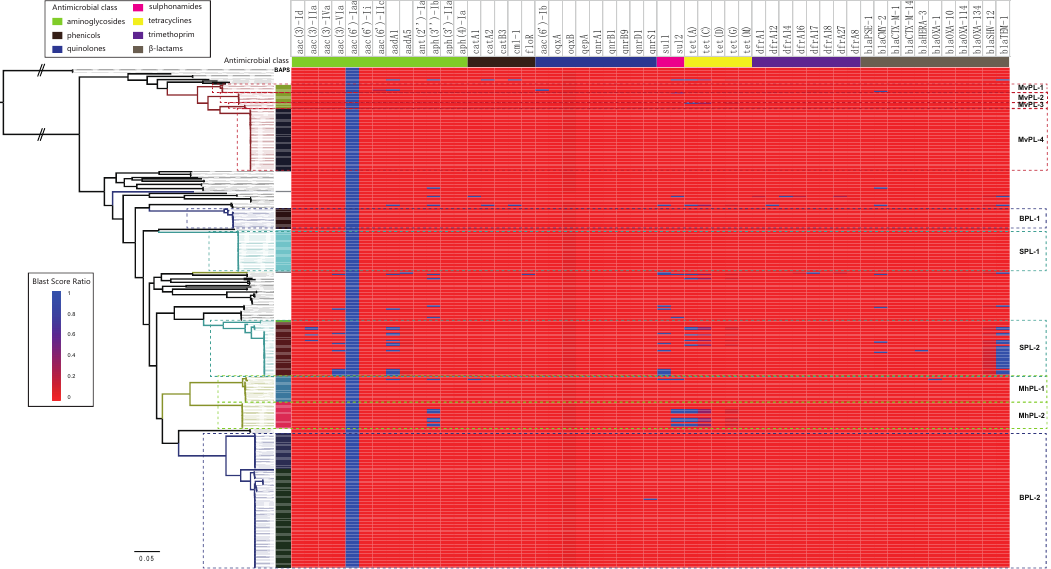
Figure 5. Heatmap of the distribution of antimicrobial resistance